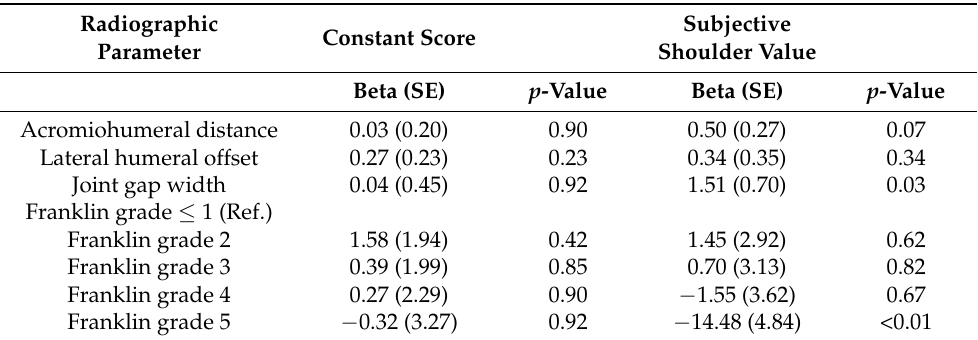
Table 3. Association between radiographic parameters and constant score and subjective shoulder value across time points.